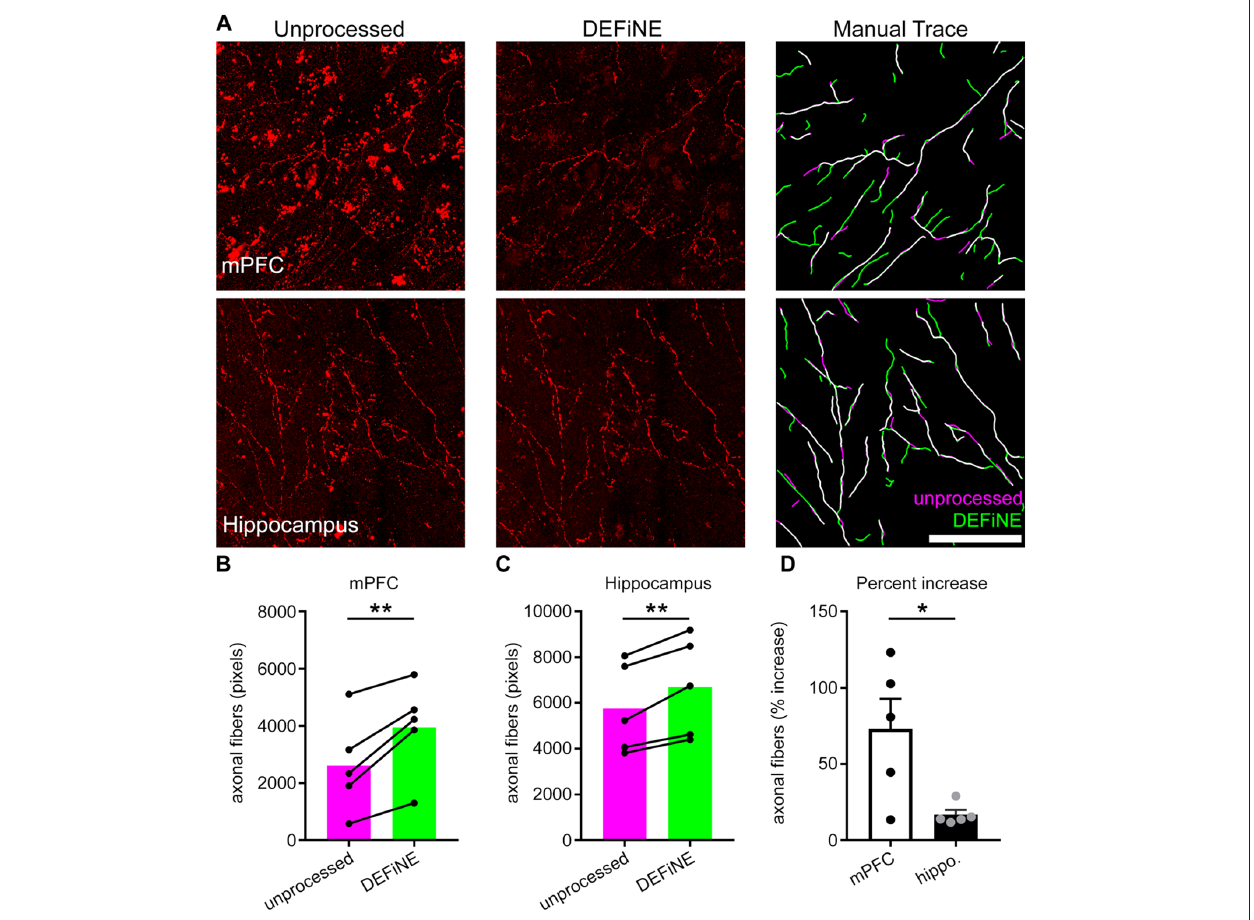
FIGURE 5 | DEFiNE processing does not result in loss of axonal fibers. (A) Axonal fibers were manually traced in unprocessed (left) and DEFiNE processed (center) fluorescent images from medial prefrontal cortex (mPFC) and area CA1 of the hippocampus. At right, the fibers traced from the unprocessed image (magenta) are shown with those traced from the processed image (green). Fibers traced in both images appear white. Scale bar: 50 µ m. (B) Axonal fibers traced before and after DEFiNE processing in five mPFC images are represented as total pixel count ( ∗∗ p = 0.008, paired t -test). (C) Fibers traced before and after DEFiNE processing in five hippocampus images ( ∗∗ p = 0.007, paired t -test). (D) Percent increase in fibers observed in DEFiNE processed images relative to unprocessed images. The increase in fiber visibility is greater in cortex ( ∗ p = 0.023, unpaired t -test).